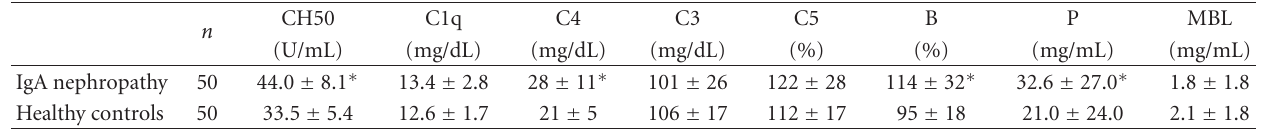
Table 1: Serum levels of complement components in patients with IgA nephropathy [7].